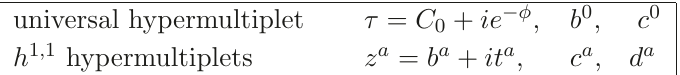
Table 1 . Type IIB hypermultiplet scalar content, whose vevs are the coordinates of